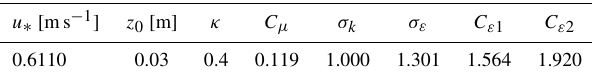
the QUICK scheme (Leonard, 1979) ( QUICKV , the vec- torial version for OpenFOAM). The k and (cid:15) equations are discretized using the first-order Upwind Discretization Scheme (UDS). The pressure is solved using the SIMPLE using a multigrid approach ( GAMG for OpenFOAM).